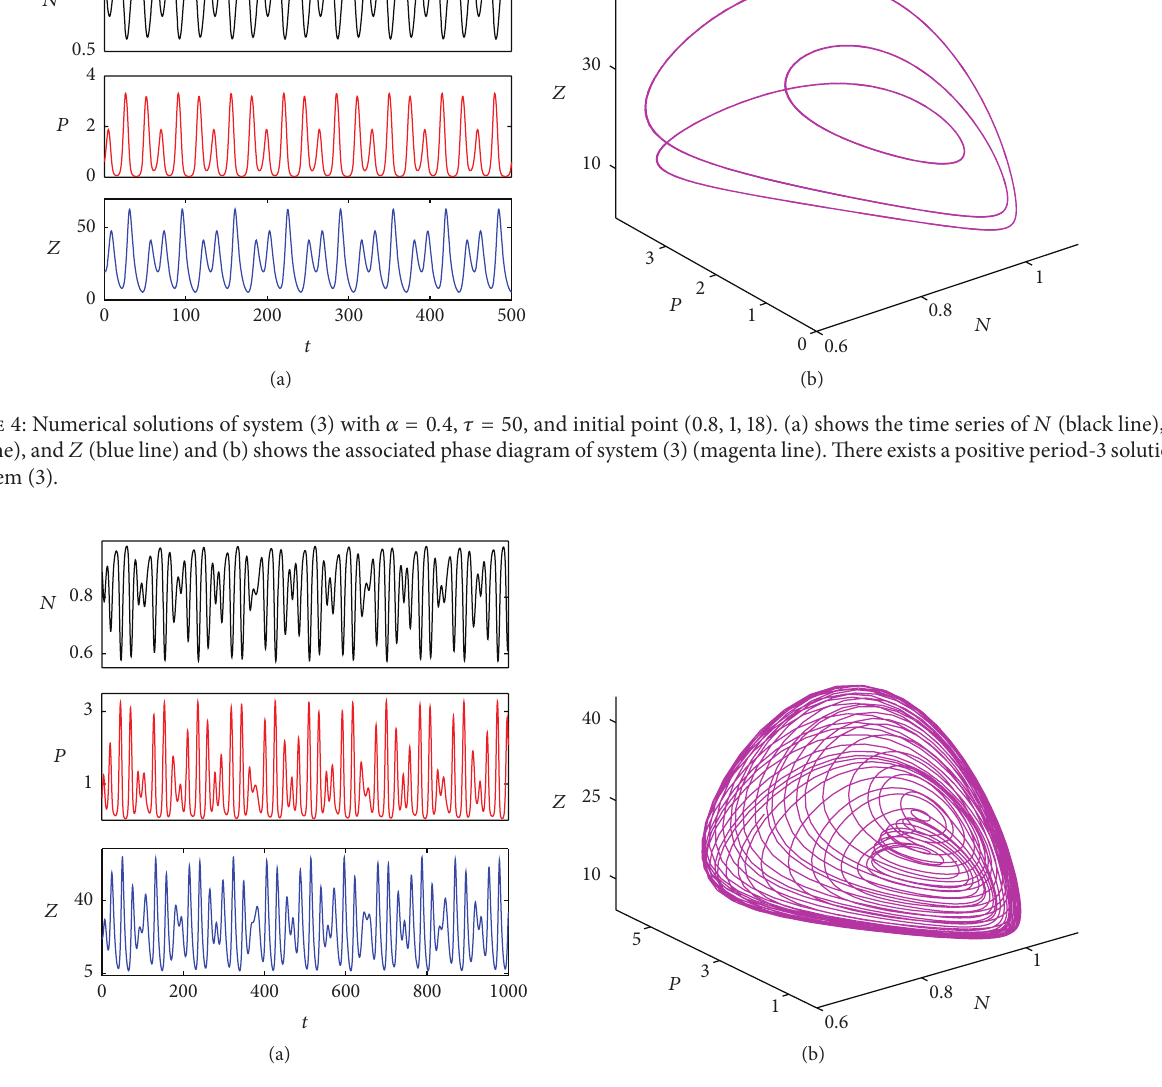
Figure 5: Numerical solutions of system (3) with 𝛼 = 0.4 , 𝜏 = 70 , and initial point (0.8, 1, 18). (a) shows the time series of 𝑁 (black line), 𝑃 (red line), and 𝑍 (blue line) and (b) shows the associated phase diagram of system (3) (magenta line). There exists a chaos attractor of system